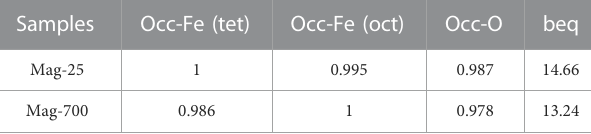
TABLE 6 The occupancy parameters of Mag-25 and